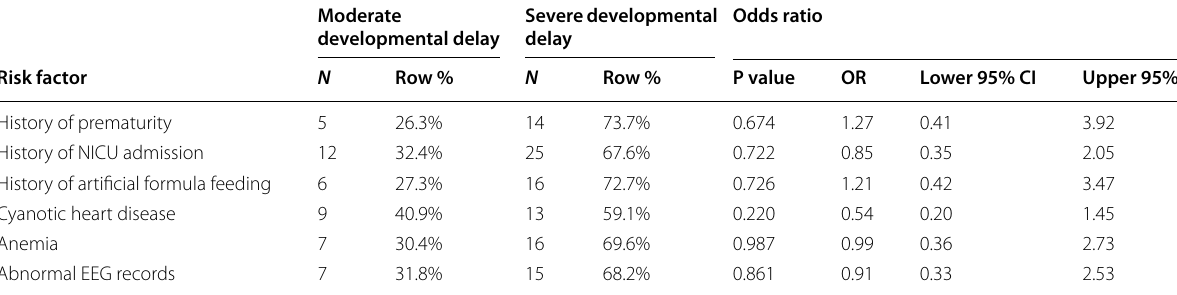
Table 5 Risk analysis for occurrence of severe developmental delay